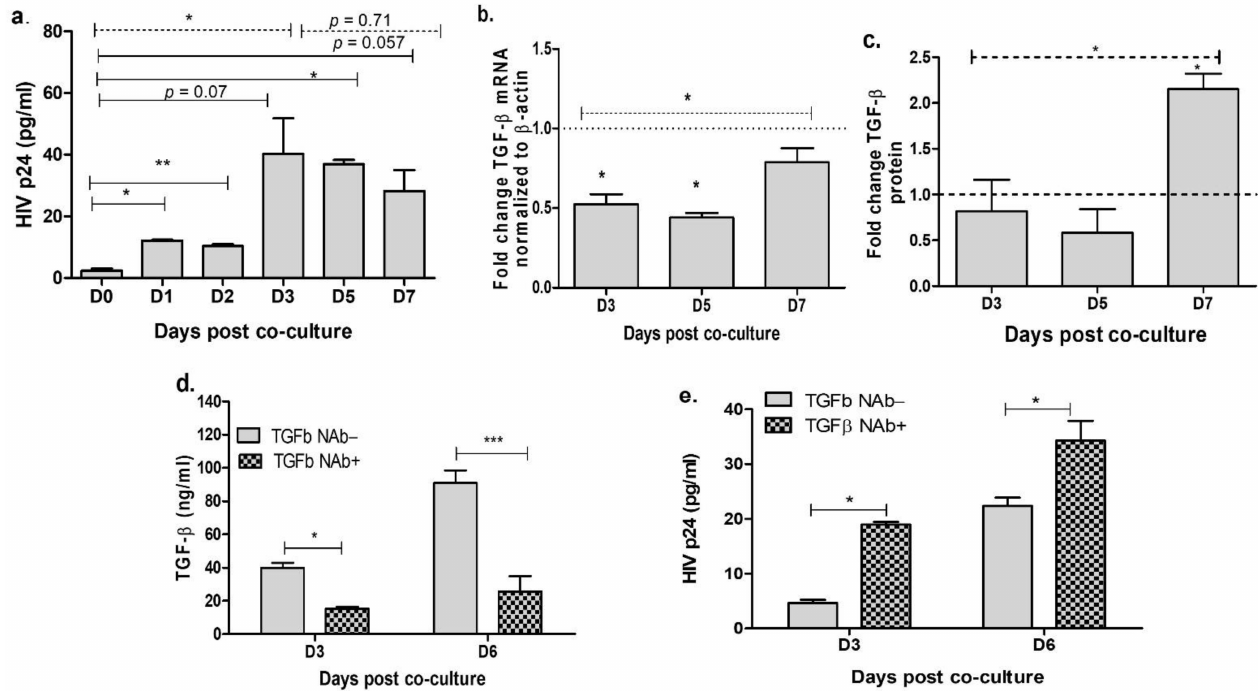
Figure 1. Neutralization of TGF- β in the cervical cells increases HIV release. JLTRG-R5 cells were infected with HIV NL4.3 (MOI = 0.1) for 48 h and co-cultured with ME-180 cells after Mitomycin-C treatment. At indicated time intervals, cells and supernatant were harvested. Supernatant was used to quantitate HIVp24 levels by ELISA ( a ). From cells RNA was extracted to quantitate TGF- β mRNA using real-time PCR. Fold change expression was calculated over the uninfected cells (baseline) which is shown as dotted line ( b ). TGF- β protein levels were determined in the supernatant using ELISA and fold change of infected cells was calculated over uninfected cells ( c ). ME-180 cells were treated with TGF- β neutralizing antibodies (NAb) for 18 h followed by co-culture with HIV infected JLTRG-R5 cells. TGF- β levels ( d ) and HIV release ( e ) was determined using ELISA at day 3 and day 6. Dotted line indicates one-way Anova analysis; solid lines indicate statistical analysis performed by unpaired Student’s t -test. Significance was determined by p value < 0.05. * indicates p value < 0.05, ** indicates p value < 0.01 and *** indicates p value <